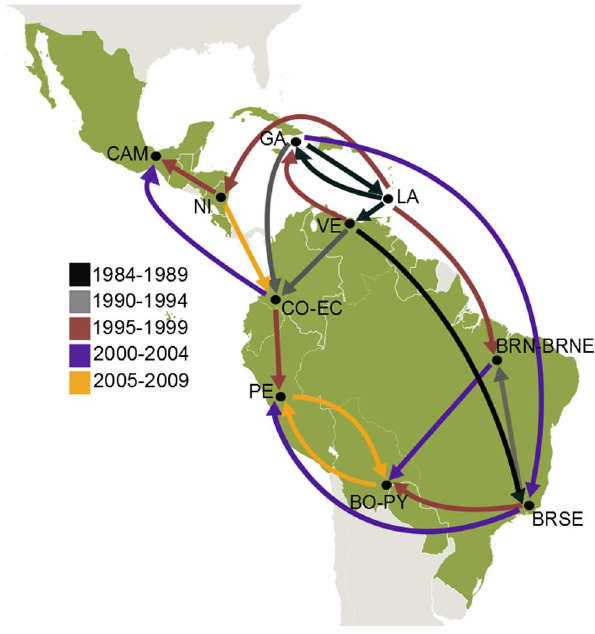
Figure 2. Spatiotemporal dynamics of dissemination of DENV- 2 AS/AM genotype in the Americas. Viral dispersal pattern between 1984 and 2009. Lines between locations represent branches in the Bayesian MCC tree along which location transitions occurs. The color of lines informs the date of the earliest viral migrations among each pair of locations. (BO-PY: Bolivia–Paraguay, BRN–BRNE: Brazil Northern-Brazil Northeastern, BRSE: Brazil Southeastern, CAM: Central America-Mexico, CO-EC: Colombia-Ecuador, GA: Greater Antilles, LA: Lesser Antilles, NI: Nicaragua, PE: Peru, VE: Venezuela)